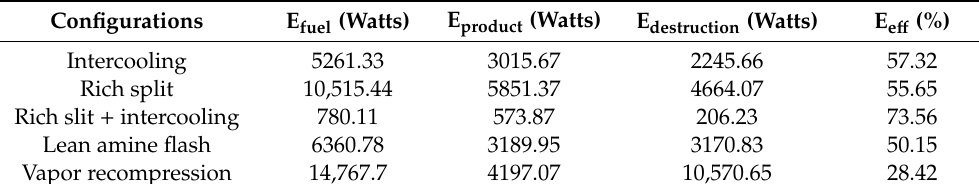
Table 8. Summary of Exergy Analysis for the Different Configurations.